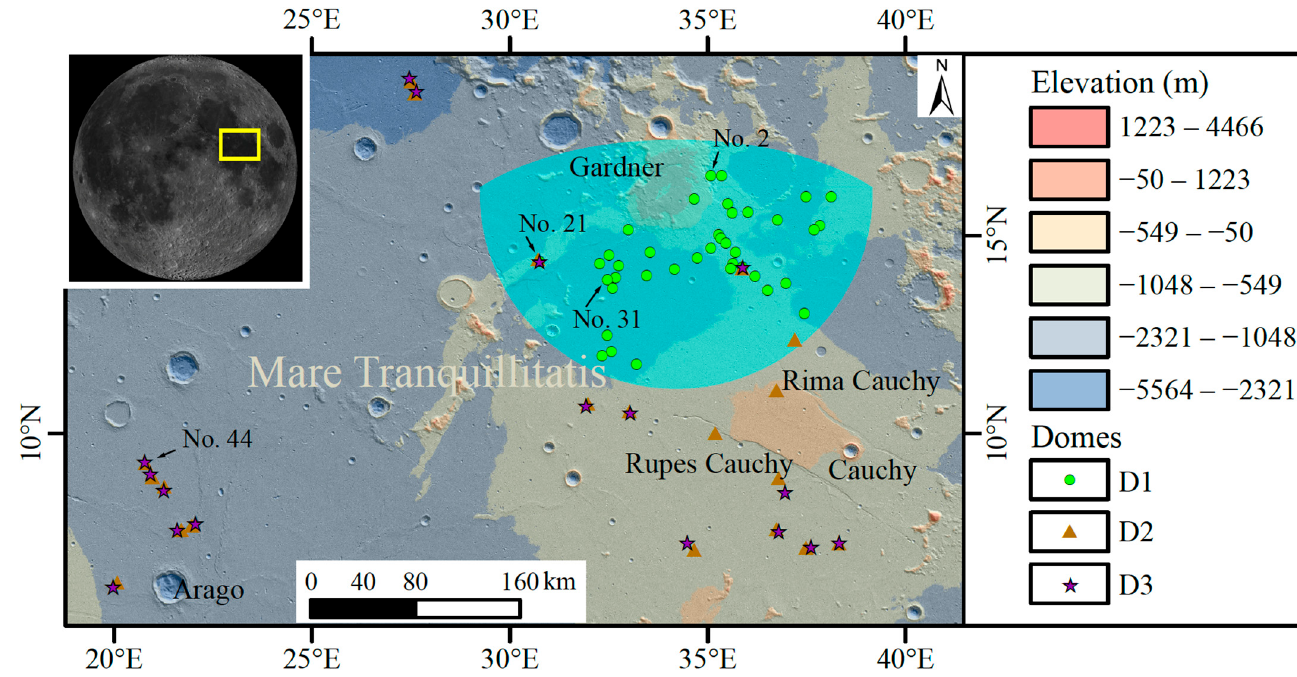
Figure 2. Locations of domes analyzed in this study. Domes labeled as D1 (green spots), D2 (brown triangles), and D3 (purple stars) represent domes that are spatially and structurally related to the Gardner volcano (cyan shaded area, maximum range without overlap with other tectonic structures, such as Rima Cauchy and Rupes Cauchy), domes identified by Wöhler et al. [2] and re-identified in this study, respectively. Domes no. 2, 21, 31, and 44 are representative domes shown in Figure 3. The background is a topographic map derived from TC DTM (digital terrain models derived from Kaguya terrain camera )data (simple cylindrical projection).